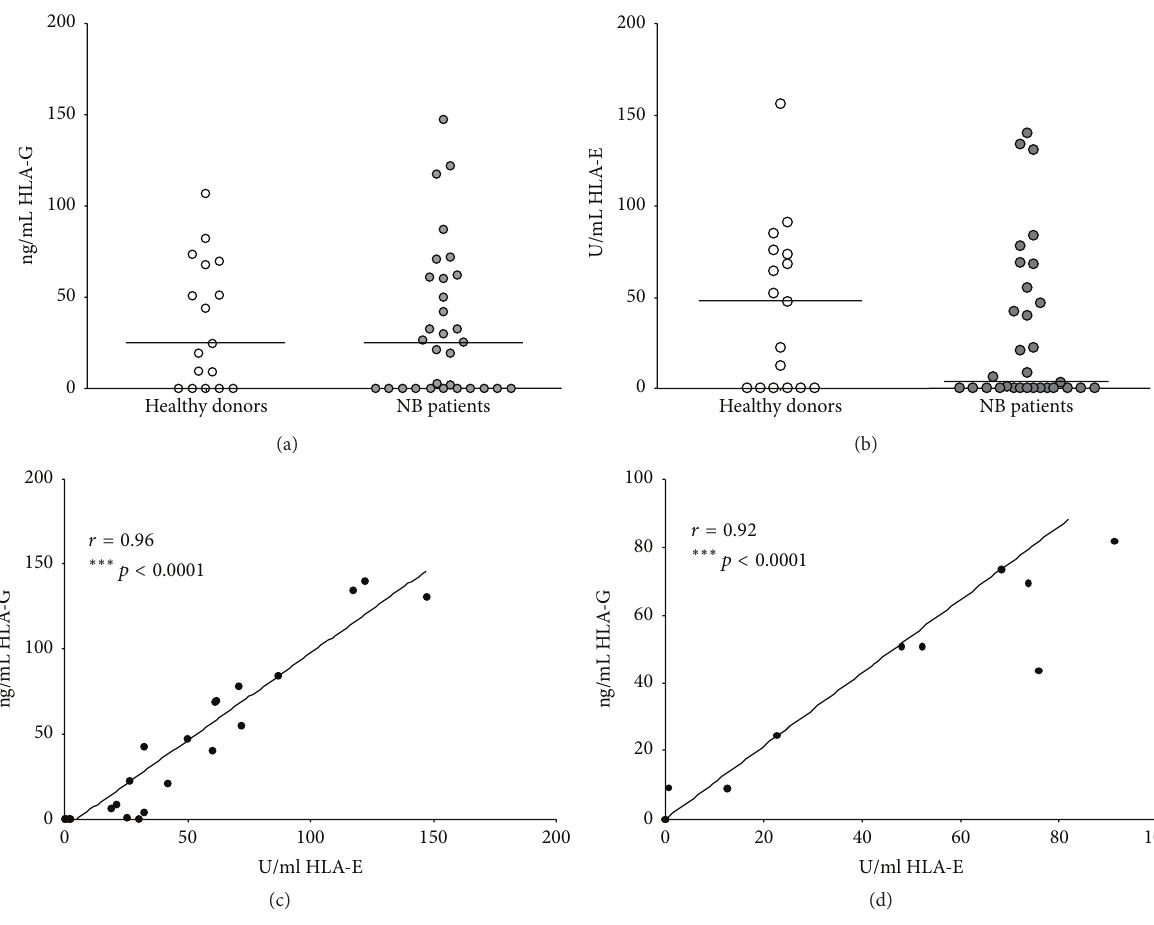
Figure 1: Levels of soluble (s)HLA-G (a) and sHLA-E (b) have been analyzed in BM plasma samples from NB patients (grey circles) and healthy BM donors (white circles). Horizontal lines indicated medians. Results are expressed as ng/ml (sHLA-G) or arbitrary units (U)/ml (sHLA-E). Correlation between BM plasma levels of sHLA-G and sHLA-E have been analyzed in NB patients (c) and controls (d). Linear regression of data and r and p values are